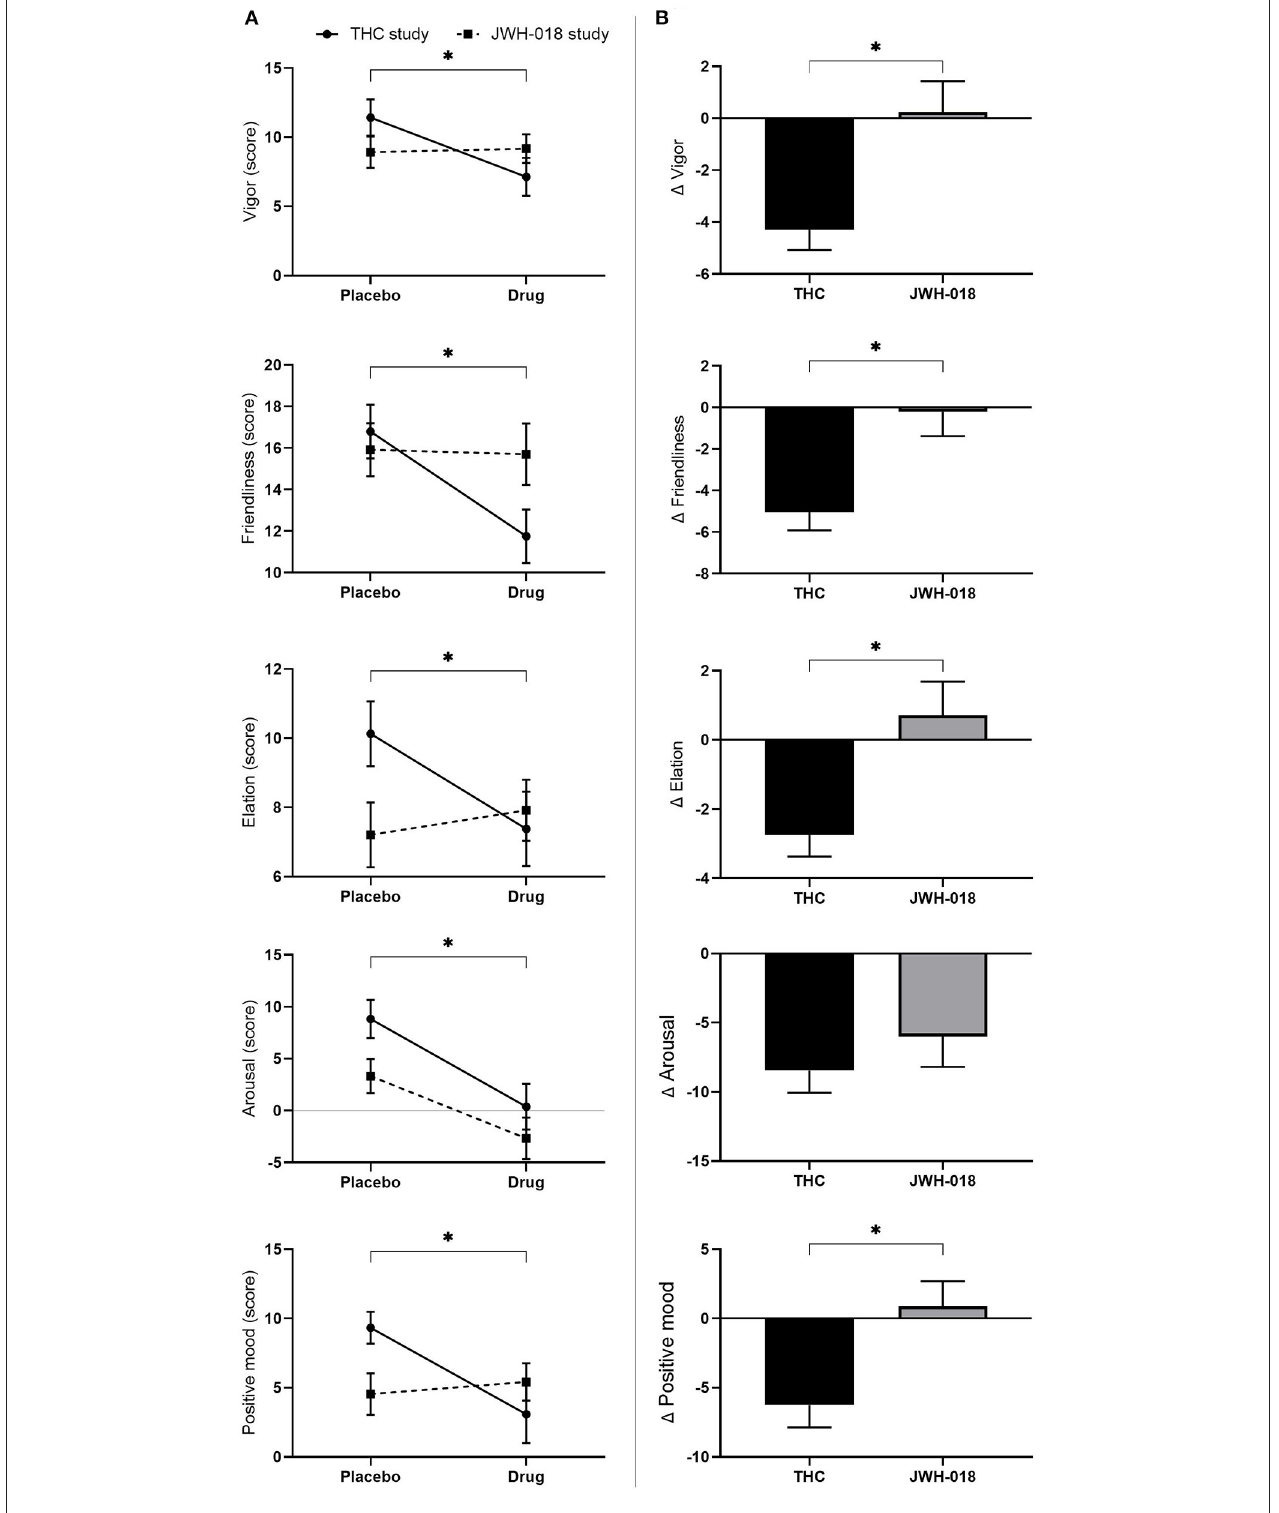
FIGURE 5 | (A) Mean (SEM) scores on the POMS scales vigor, friendliness, elation, arousal, and positive mood, for placebo and drug conditions, in the THC and JWH-018 study. *Significant difference between the active condition (THC/JWH-018) and placebo. (B) Scores on the POMS scales vigor, friendliness, elation, arousal, and positive mood for both drug conditions shown as difference scores (relative to placebo). *Significant differences between THC and JWH-018.